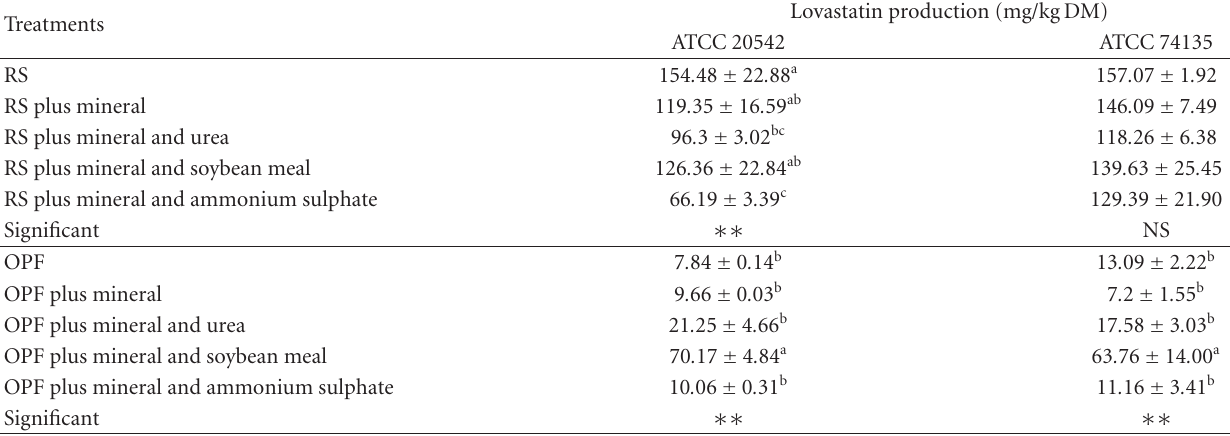
Table 1: E ff ect of nitrogen source and mineral solution on lovastatin production in solid state fermentation by A. terreus using rice straw (RS) and oil palm frond (OPF) as